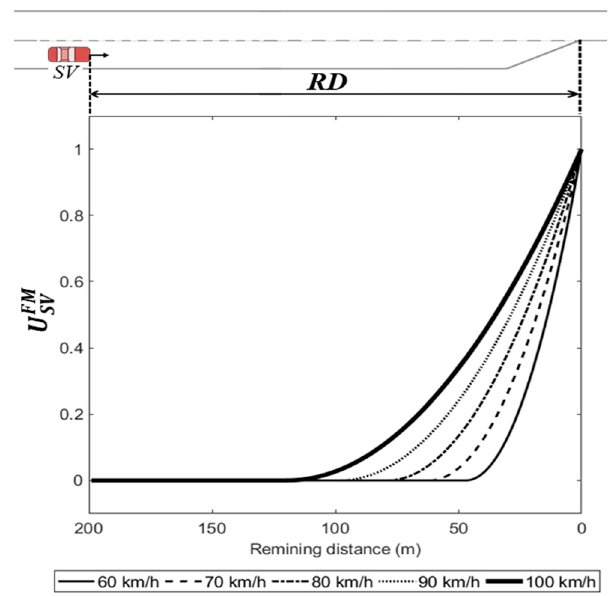
Figure 6. Forced merging payoff by the remaining distance at various speeds.